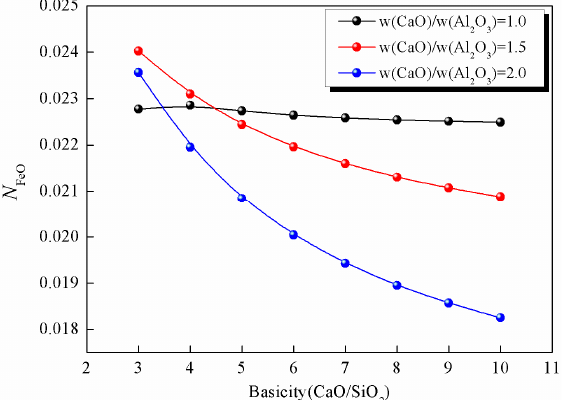
Figure 5. Effect of w(CaO)/w(Al 2 O 3 ) mass ratio on the optimal alkalinity.